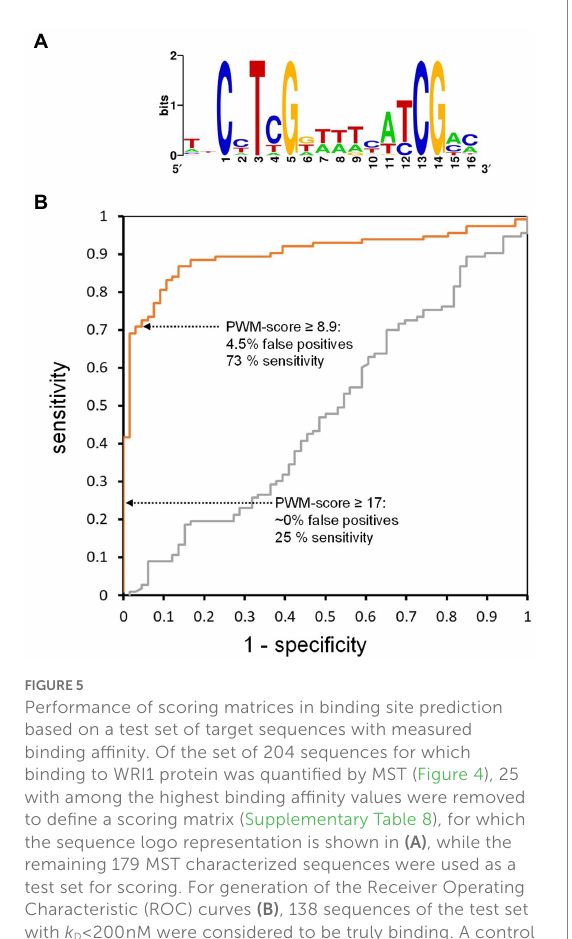
FIGURE 5 Performance of scoring matrices in binding site prediction based on a test set of target sequences with measured binding affinity. Of the set of 204 sequences for which binding to WRI1 protein was quantified by MST (Figure 4), 25 with among the highest binding affinity values were removed to define a scoring matrix (Supplementary Table 8), for which the sequence logo representation is shown in (A) , while the remaining 179 MST characterized sequences were used as a test set for scoring. For generation of the Receiver Operating Characteristic (ROC) curves (B) , 138 sequences of the test set with k D < 200 nM were considered to be truly binding. A control curve (gray) was generated after random shuffling of the 179 k d values in the test set. The area under the ROC control curve is close to 0.5 as expected for random guessing (Fawcett, 2006).